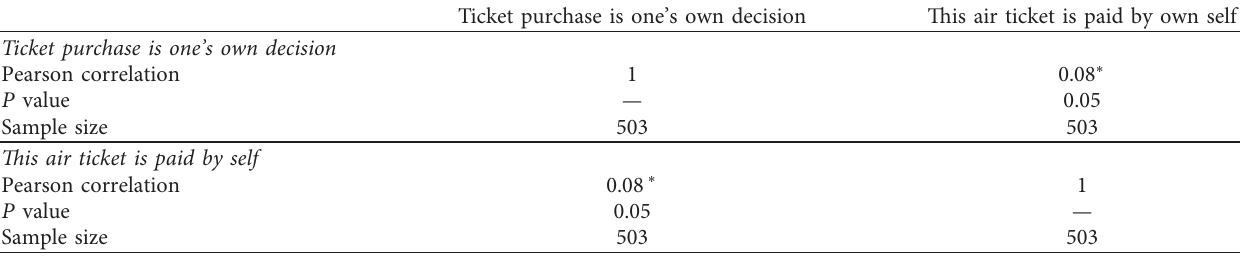
Table 7: Correlation coefficient analysis results.